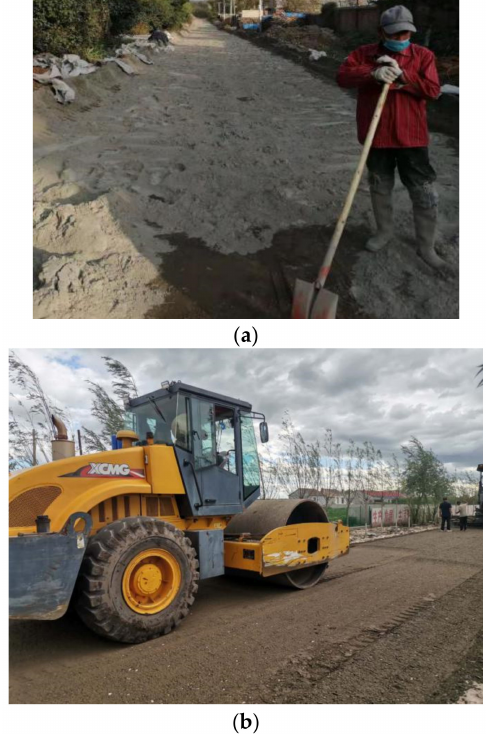
Figure 16. The main construction process. ( a ) Mixing. ( b ) Compaction.